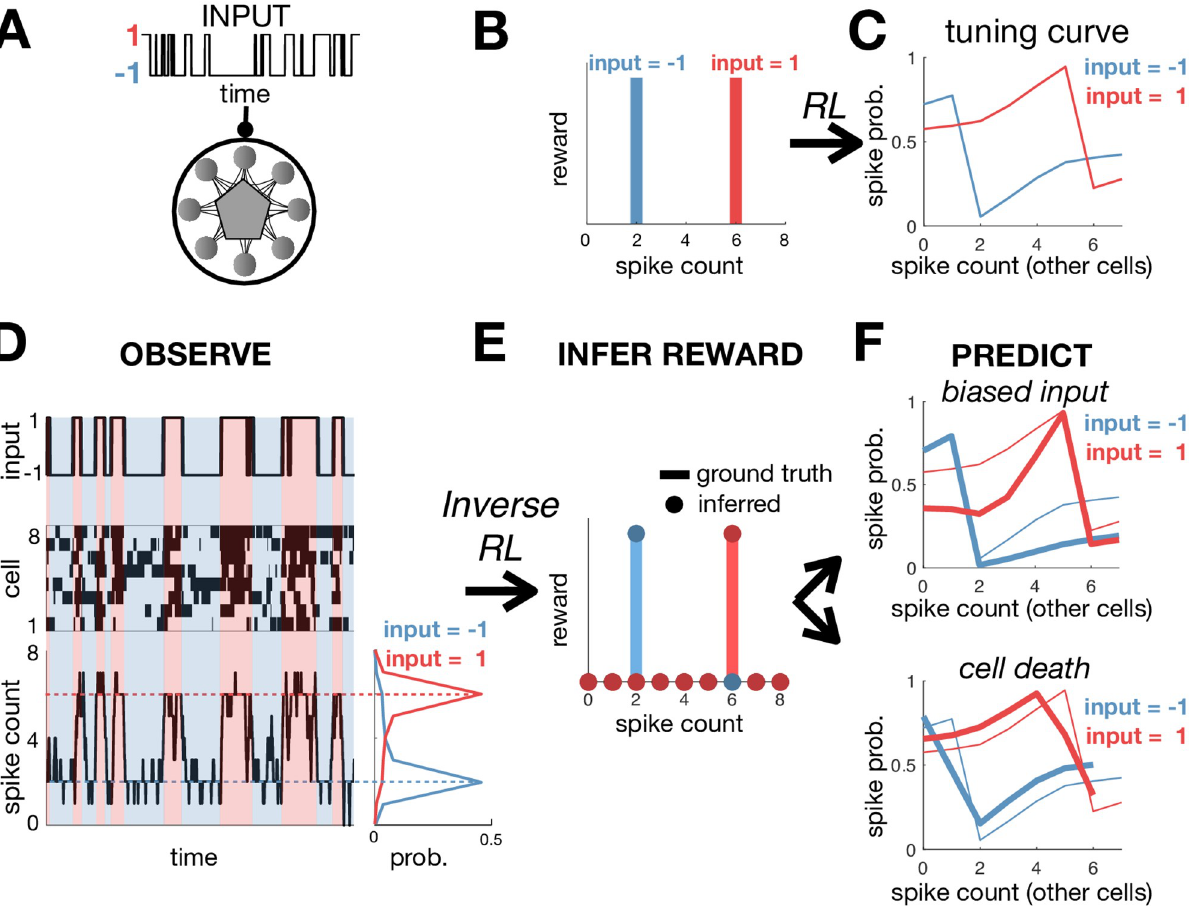
Fig 2. Training and inferring the function performed by a neural network. ( A ) A recurrent neural network receives a binary input, x . ( B ) The reward function equals 1 if the network fires 2 spikes when x = − 1, or 6 spikes when x = 1. ( C ) After optimisation, neural tuning curves depend on the input, x , and total spike count. ( D ) Simulated dynamics of the network with 8 neurons (left). The total spike count (below) is tightly peaked around the rewarded values. ( E ) Using inverse RL on the observed network dynamics, we infer the original reward function used to optimise the network from its observed dynamics. ( F ) The inferred reward function is used to predict how neural tuning curves will adapt depending on contextual changes, such as varying the input statistics (e.g. decreasing p ( x = 1)) (top right), or cell death (bottom right). Thick/thin lines show adapted/original tuning curves, respectively.